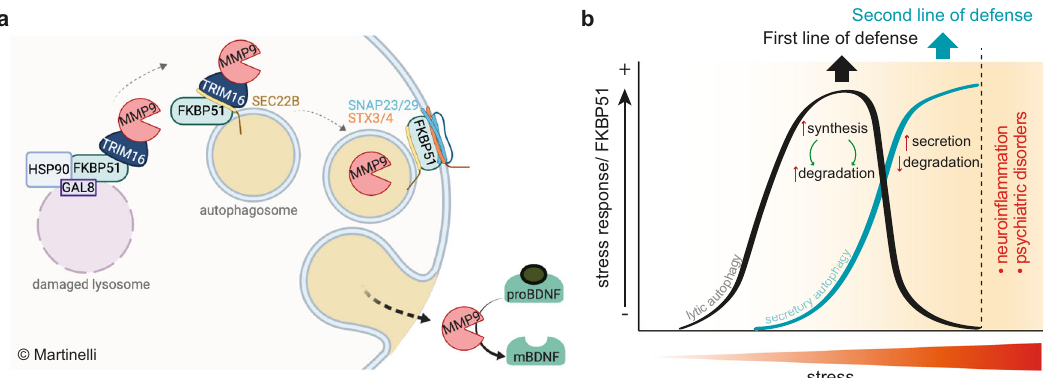
Fig. 7 Proposed model based on the fi ndings. a Glucocorticoid-mediated stress induces lysosomal damage, which leads to the association of FKBP51 with the cargo receptor TRIM16 and the cargo protein (e.g., MMP9). This complex is transported on the autophagosome membrane via the interaction of FKBP51 with SEC22B. The cargo protein is internalized into the autophagosome which is transported to the plasma membrane. The vesicle-plasma membrane fusion is mediated via the SNARE-protein complex assembly, which is regulated by FKBP51 and sensitive to glucocorticoids. The membrane fusion leads to the release of the cargo proteins into the extracellular milieu. The increased secretion of extracellular MMP9 induces the cleavage of proBDNF to its mature form, which becomes the prevailing form in the extracellular space; b A fi rst response to stress triggers lytic autophagy 10 . In case the stress persists, a second defense line is activated which switches the stress response from lytic to secretory autophagy. If stress further persists (e.g. chronic stress), the initially bene fi cial proteins secreted in response to stress, might lead to neuroin fl ammation and psychiatric